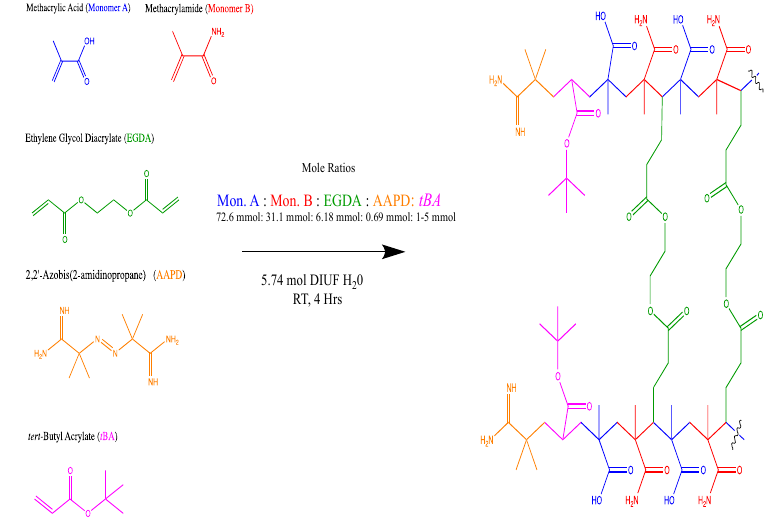
Figure 1. Purposed repeating unit upon ideal arrangement. Shown synthetic scheme is for non-imprinted